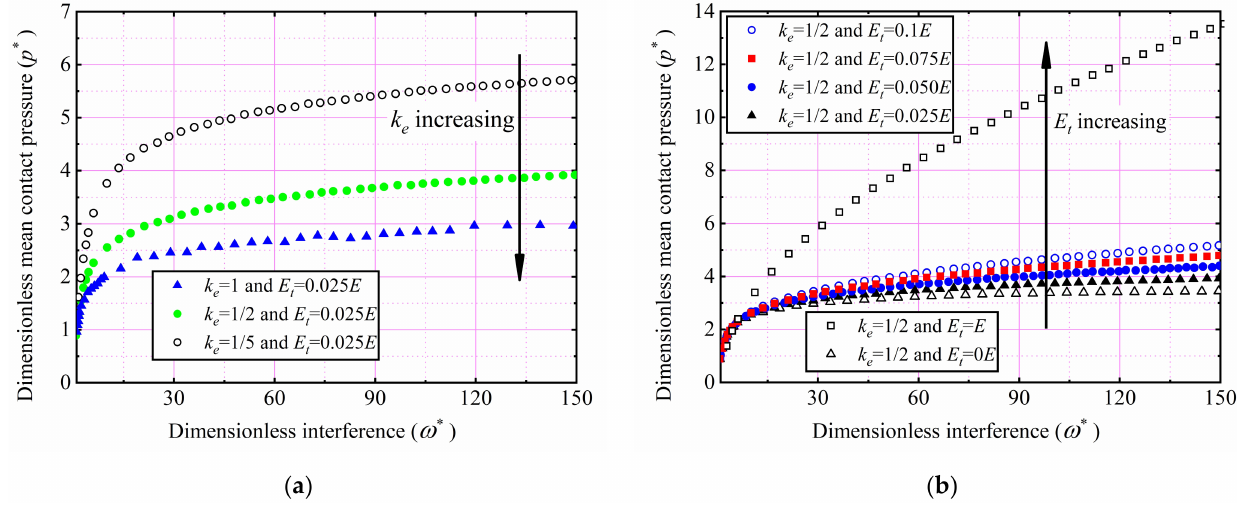
Figure 7. Evolution of p * with increasing ω * : ( a ) under different k e values; ( b ) under different E t values.